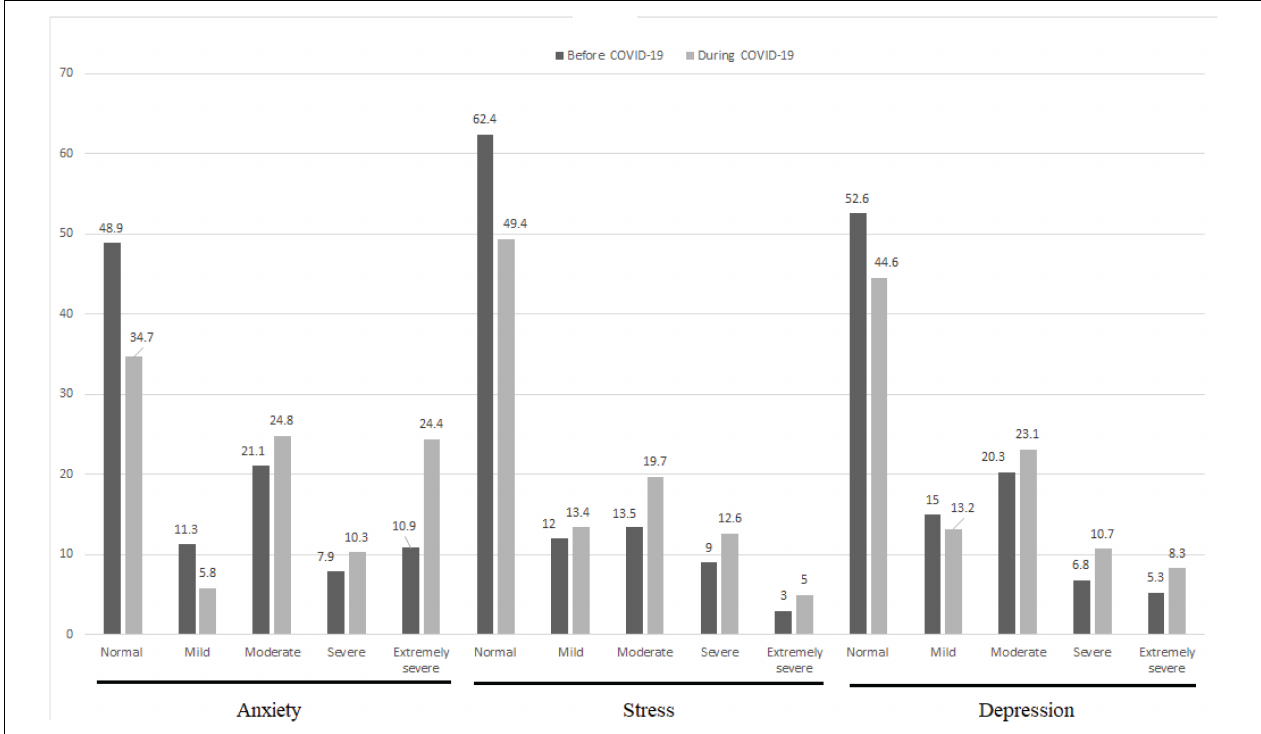
FIGURE 2 | The comparison of the level of anxiety, stress, and depression score before COVID-19 and during the first wave of the COVID-19